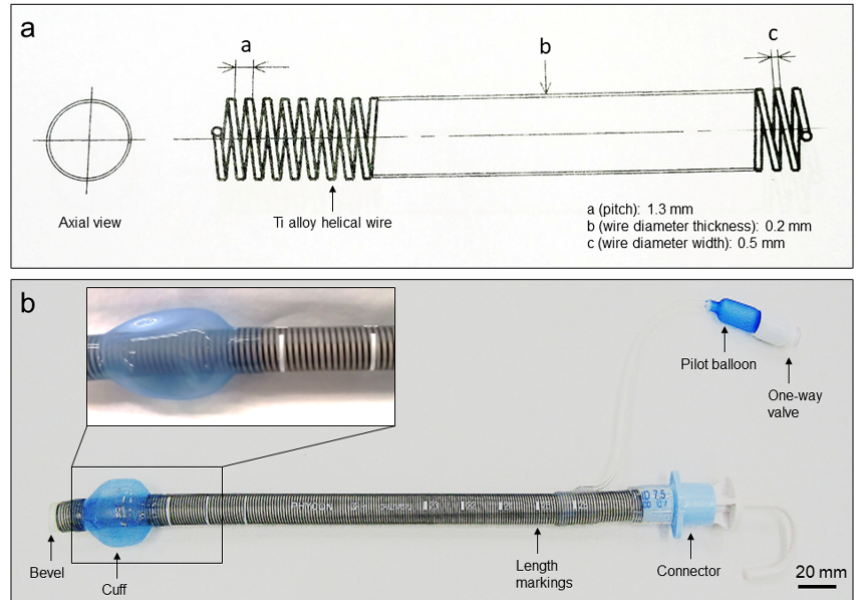
Figure 1. The novel MRI-compatible Ti alloy helical wire-reinforced endotracheal tube (Ti-rET). ( a ) Blueprint of the Ti-rET. a, pitch 1.3 mm; b, wire diameter thickness 0.2 mm; c, wire diameter width 0.5 mm ( b ) An overview of the Ti-rET.